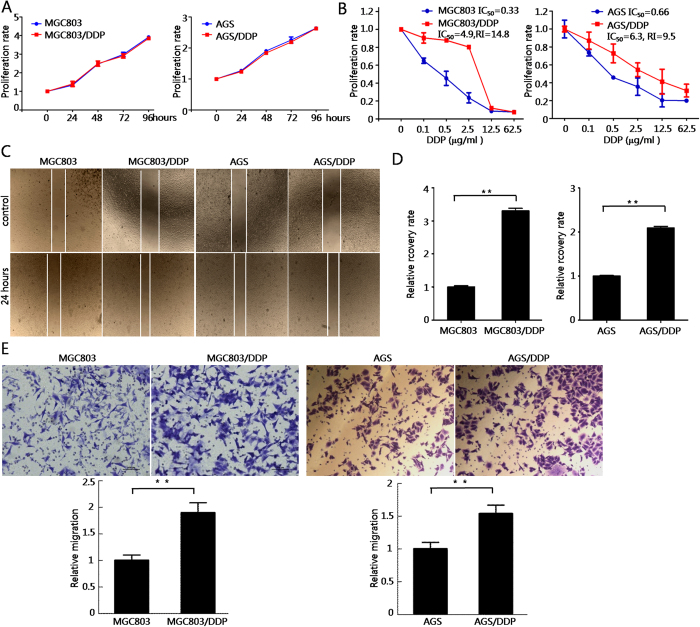
Cisplatin-resistant gastric cancer cell models display higher motility.(A) Cell growth curve of cisplatin-resistant MGC803 and AGS cells, versus parental MGC803 and AGS cells. Values represented the mean ± SD from two independent experiments with triplicate samples. DDP, cisplatin. (B) IC50 and RI for DDP in drug resistant and parental gastric cancer cells. Values represented the mean ± SD from three independent experiments with triplicate samples. RI, resistance index. (C) Cisplatin-resistant gastric cancer cells exhibit higher wound healing ability. Photos were taken at 0 and 24 h after wounding. (D) Summary of wound healing assays. Results were presented as the mean ± SD of two independent experiments, **P < 0.01 compared with parental cells. (E) Cisplatin-resistant gastric cancer cells possess higher cell migratory capacity in vitro. The results were mean ± SD of three independent experiments with triplicate wells. **P < 0.01.